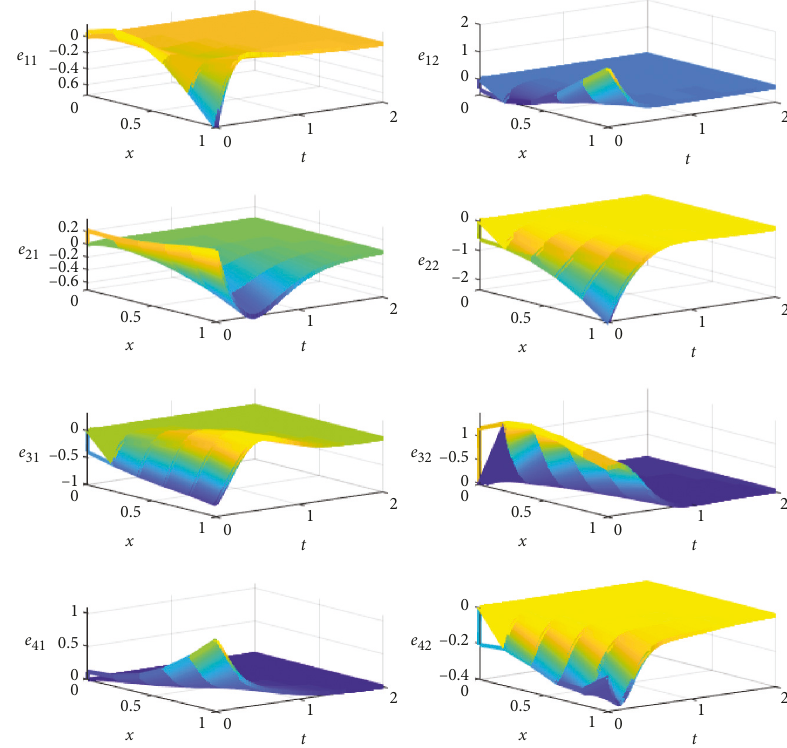
Figure 2: The closed-loop profile of z